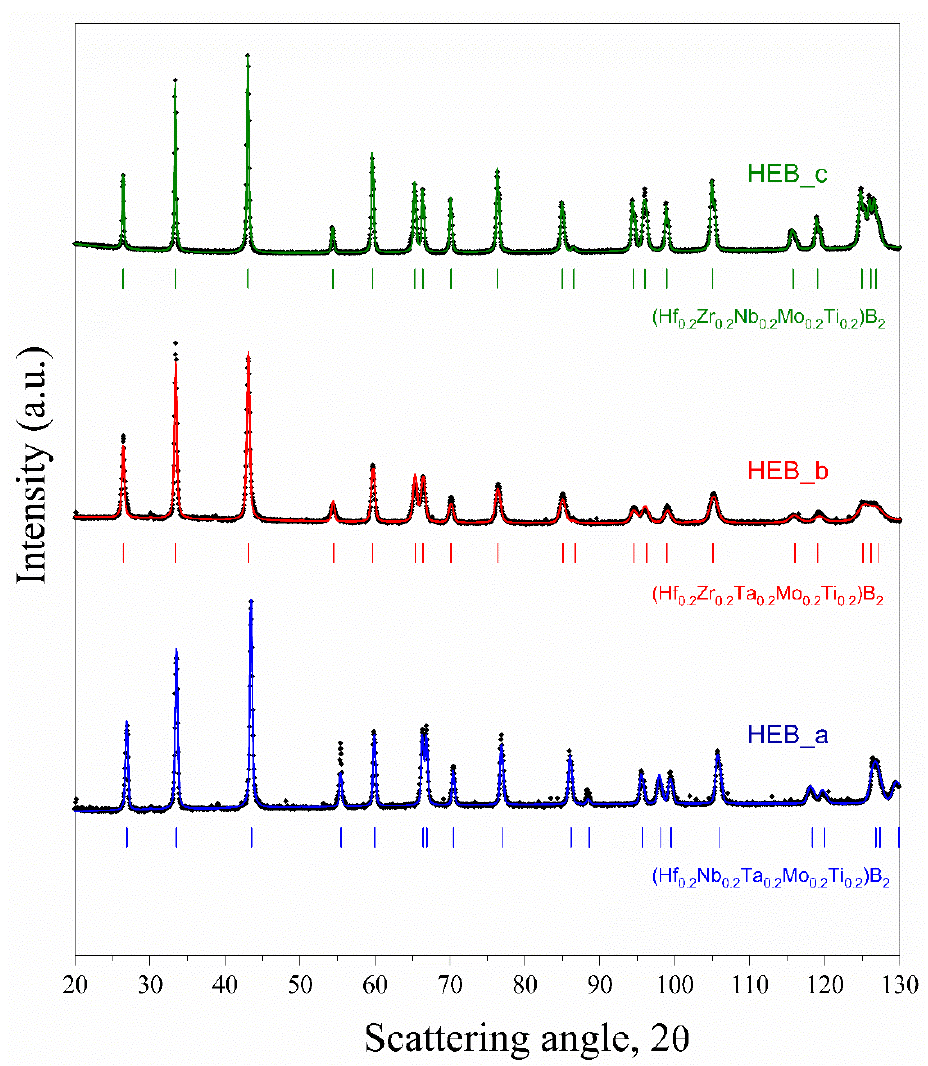
Figure 3. XRD pattern and related Rietveld refinement of dense HE products obtained by SPS.